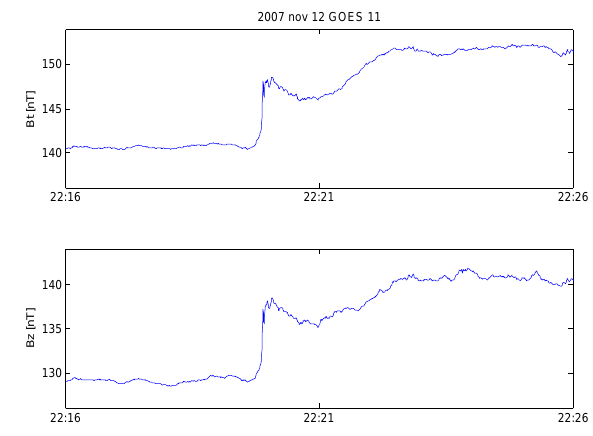
Fig. 3. 12 November 2007: GOES-11 observations at 13.4 MLT: the total magnetic field B t [nT] and z-component of the magnetic field B z [nT] in the GSM coordinate system.